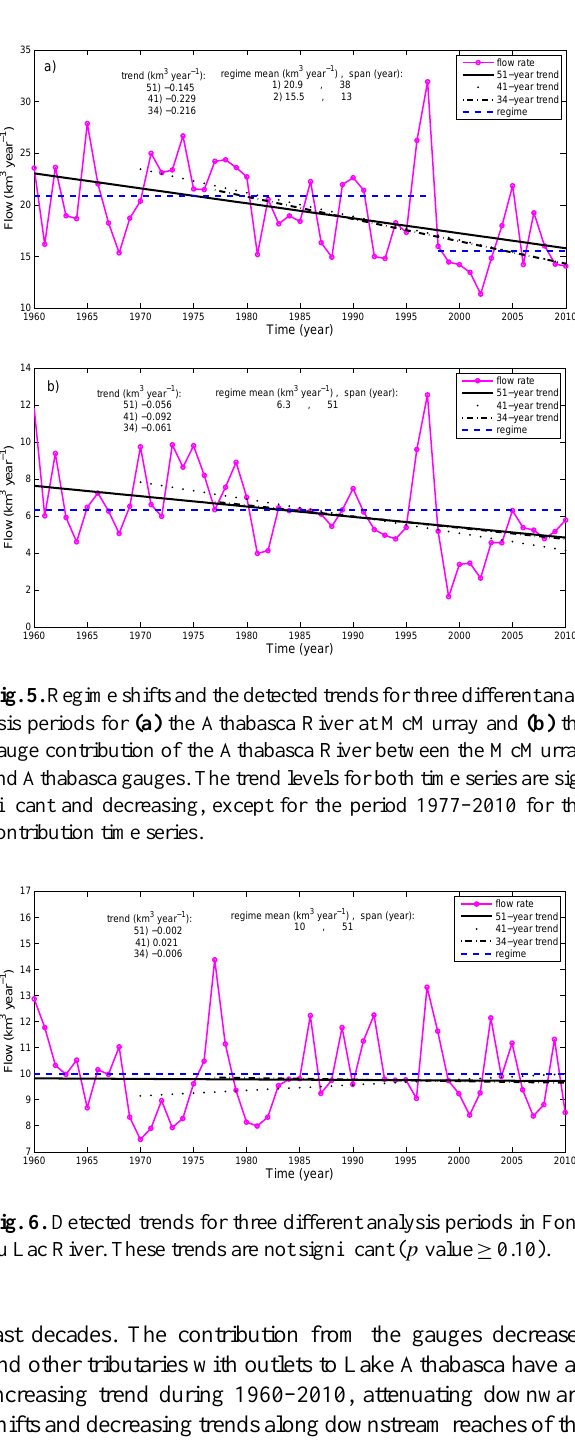
last decades. The contribution from the gauges decreases and other tributaries with outlets to Lake Athabasca have an increasing trend during 1960–2010, attenuating downward shifts and decreasing trends along downstream reaches of the Athabasca River. Over the last 51 yr, the volume of lake in- flow has declined 7.22 km 3 , which accounts for about 21.2 % of annual average inflow in that period. The relative changes are − 26.9 % and − 37.9 % at the Athabasca and McMurray gauges. The analyses of variability of the Lake Athabasca in- flow and detected trends and regime changes over 1960–2010 are assessed without consideration of their driving mecha- Fig.7. InputflowratetotheLakeAthabascafromothersmallriversandthedetectedtrendsforthreedifferentanalysisperiods.Thesetrends arenotsignificant( p -value ≥ 0.10).